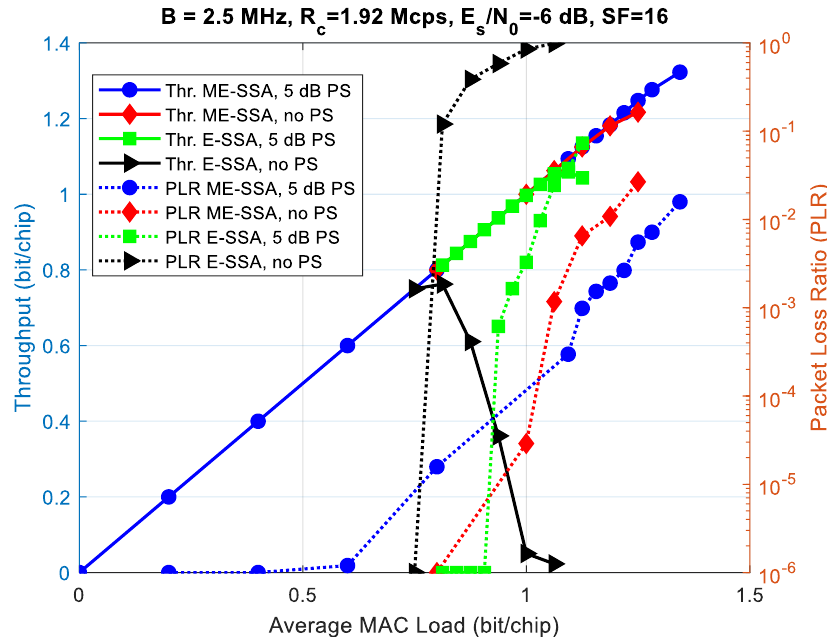
Figure 17. Simulated E-SSA and ME-SSA throughput and PLR performance with and without power randomization (PR), 3GPP FEC coding rate 1/3 with block size of 1200 bits, spreading factor of 16 and E s /N 0 = 6 dB.